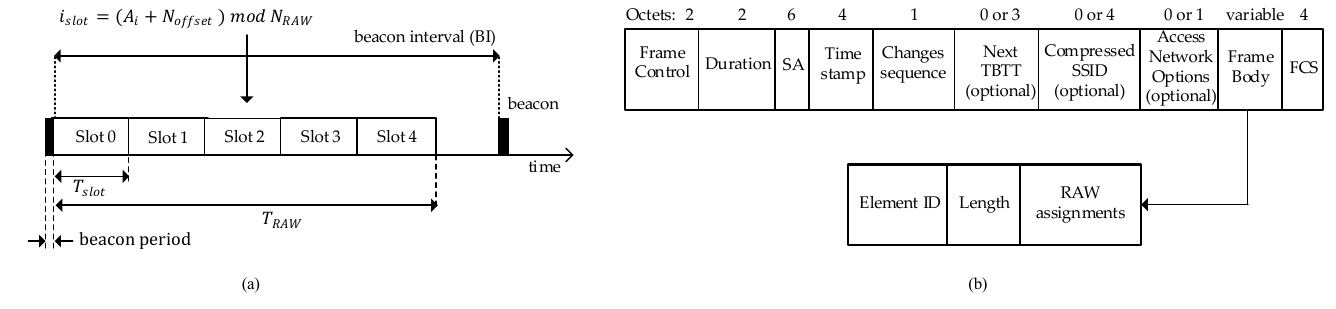
Figure 6. Time allocation in BI: ( a ) RAW of IEEE 802.11ah; ( b ) beacon frame and RPS element. However, RAW-related information is included in the RAW parameter set (RPS) element that is contained within the frame body subfield of the beacon frame, as